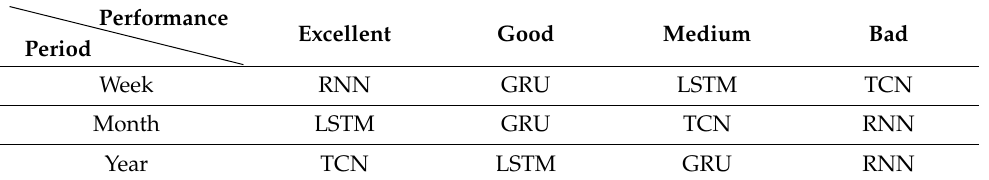
Table 10. Performance comparison of four DNN models for wind power forecasting.